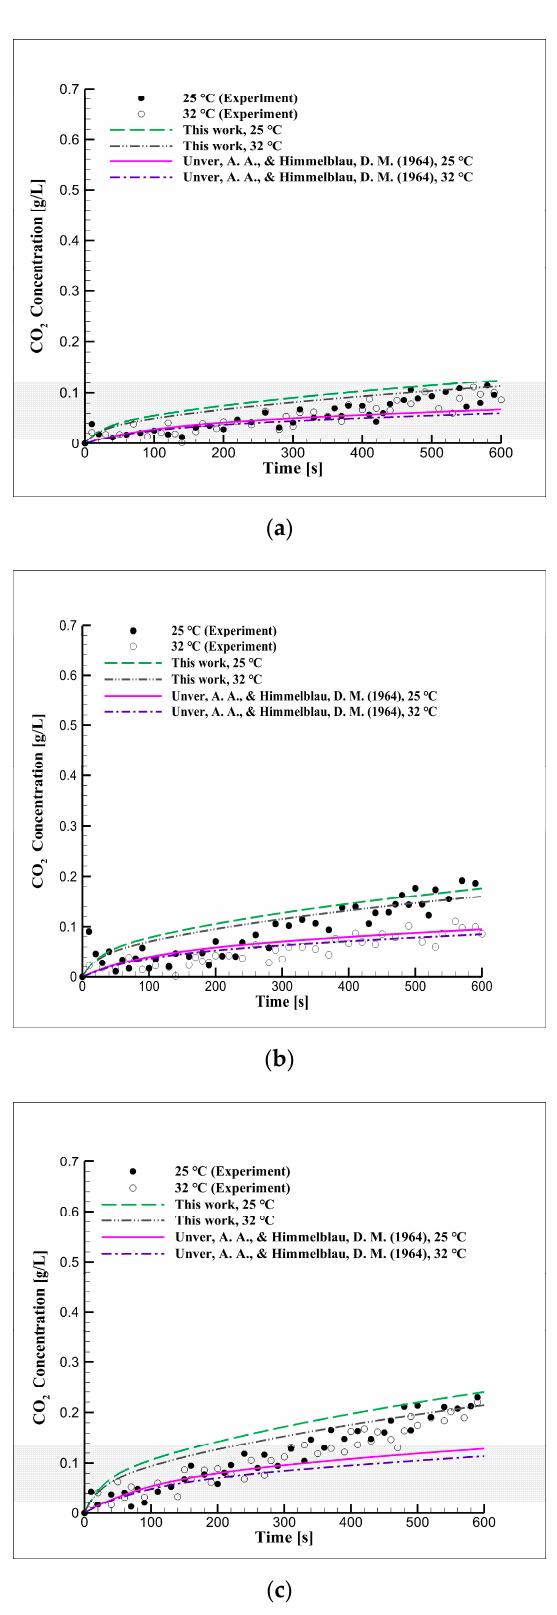
Figure 4. Mid-term CO 2 concentration over time due to changes in the equilibrium pressure and temperature in distilled water at pressures of ( a ) 2, ( b ) 3, and ( c ) 5 bar.